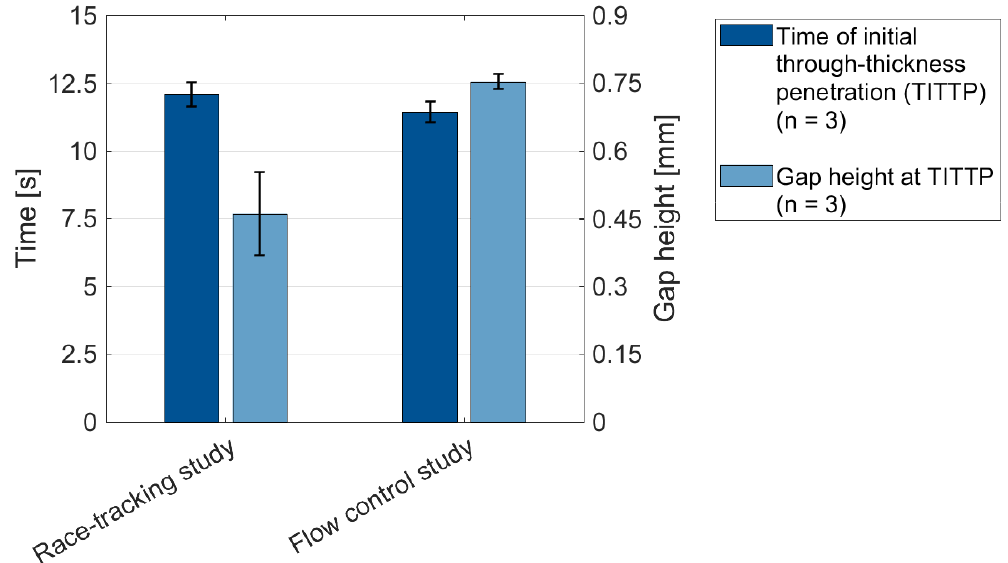
Figure 12. Time of initial through-thickness penetration (TITTP) and corresponding gap height of FS-CRTM experiments without a race-tracking channel from the race-tracking study and the flow control study. Shown are mean values and standard deviations for experiments in triplicate.